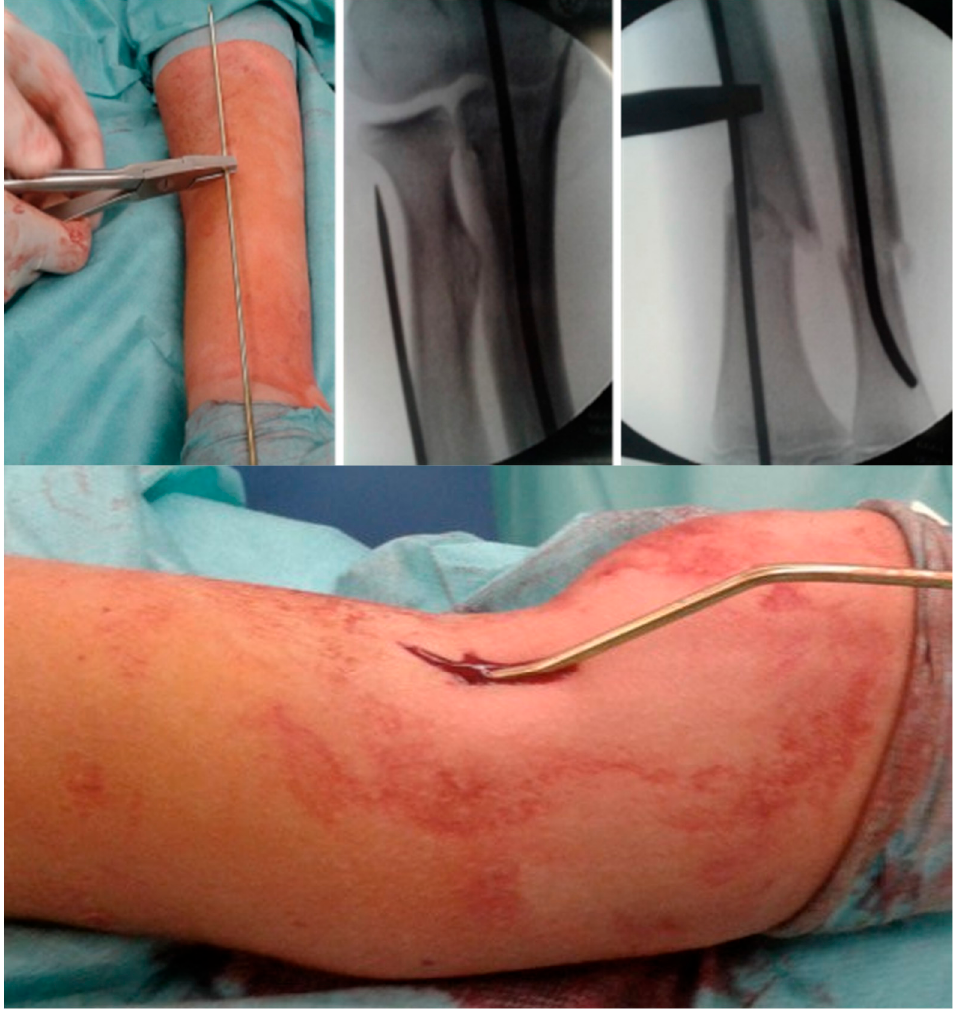
Figure 2. Determine diameter of nail and distance between skid and proximal kink (fluoroscopy). The skid should finally be placed in the radial neck, the first kink 1 cm proximal of the fracture. The second kink is performed before the first is pushed into the bone.